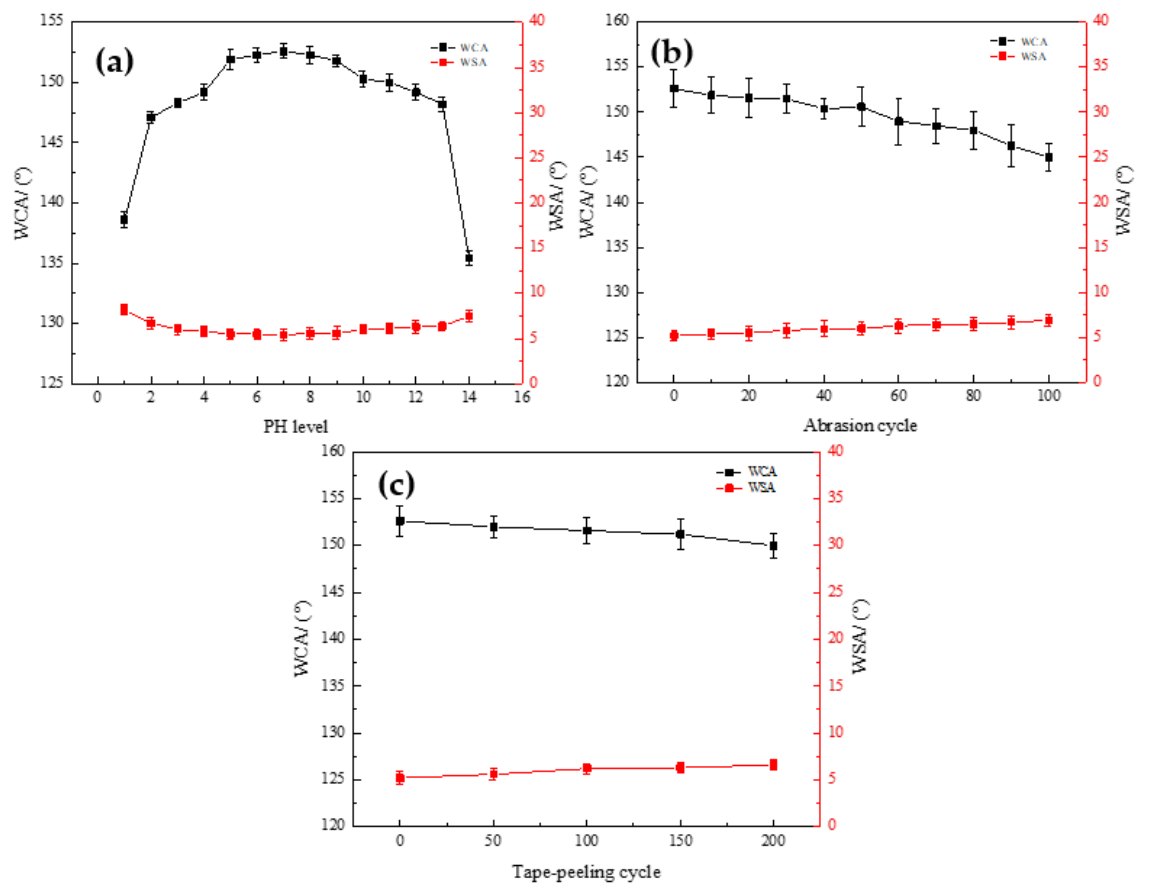
Figure 13. Mechanical Stability of the Coating. ( a ) Water CA and SA result over corrosive bath immersion in different pH range. ( b ) Changes in water CA and SA of the coating over 100 abrasion cycles. ( c ) Changes in water CA and SA of the coating over 200 tape-peeling cycles.